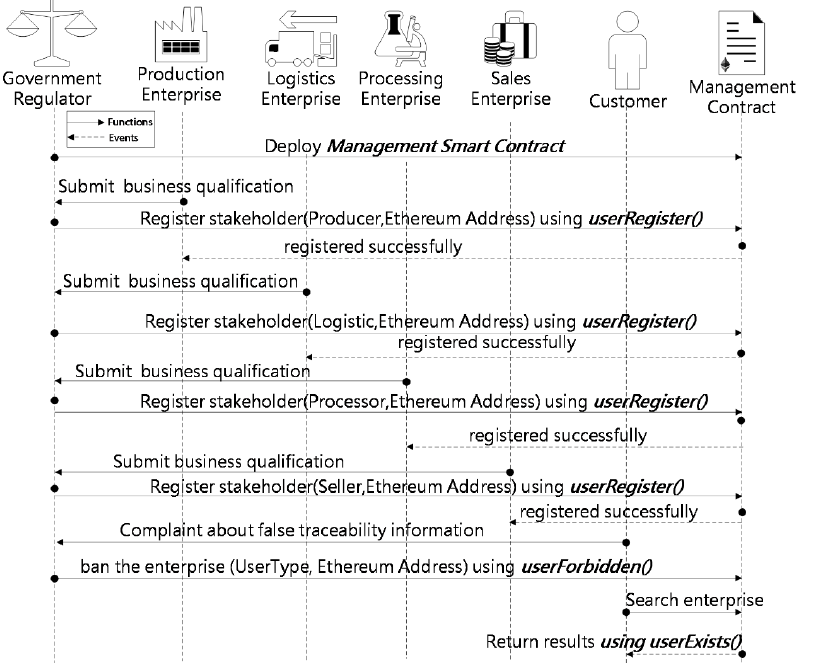
Figure 6. Sequence diagram showing interactions among the stakeholders with the Management smart contract. smart contract.